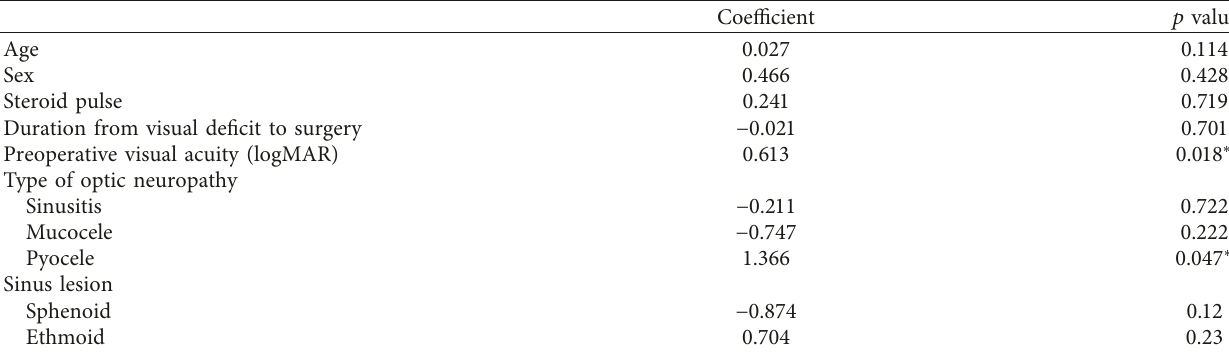
Table 3: Univariate regression on postoperative visual